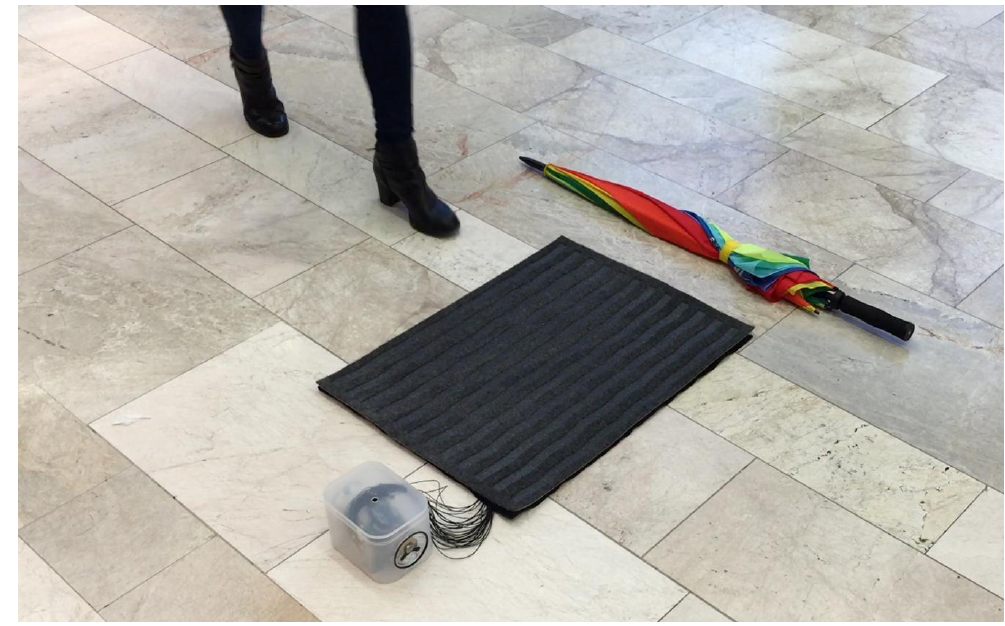
Figure 4. Prototype in action.